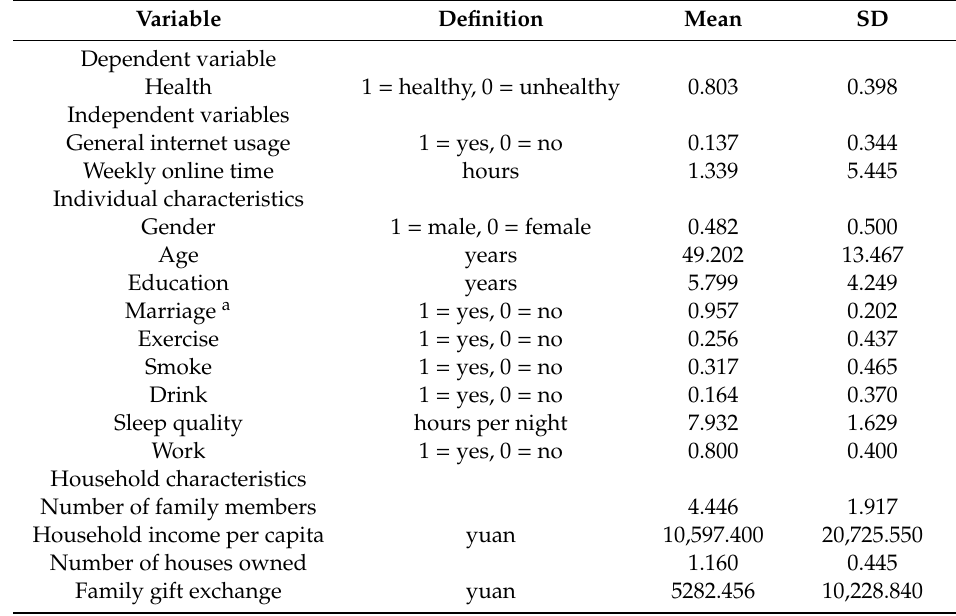
Table 1. Baseline characteristics of rural adults. SD: standard